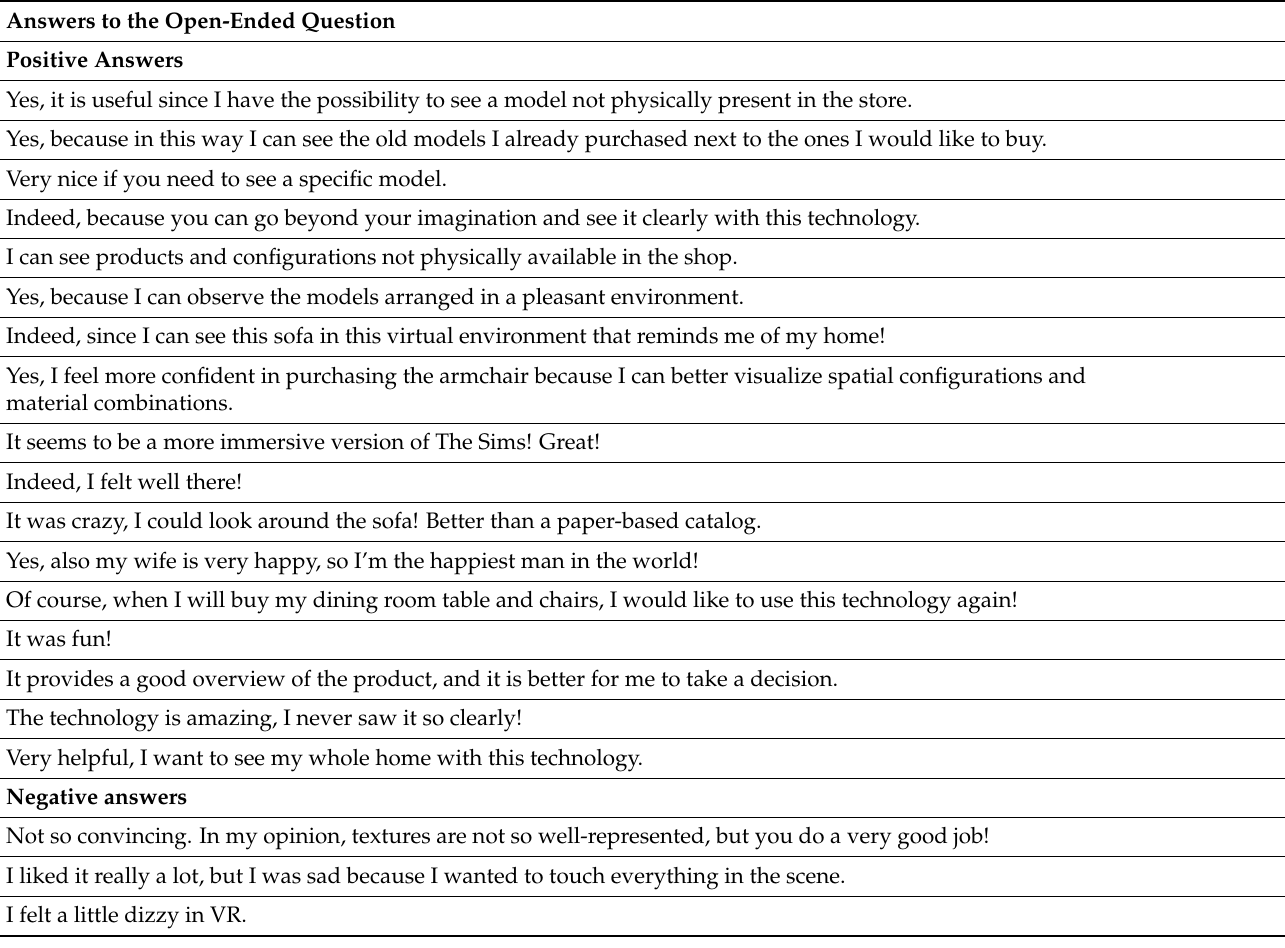
Table A2. Most relevant answers to the open-ended question of the